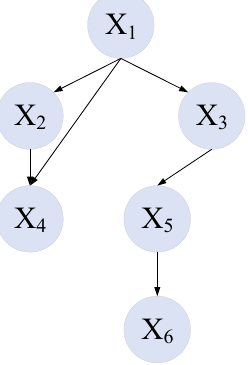
Figure 2. Example of a Bayesian network.